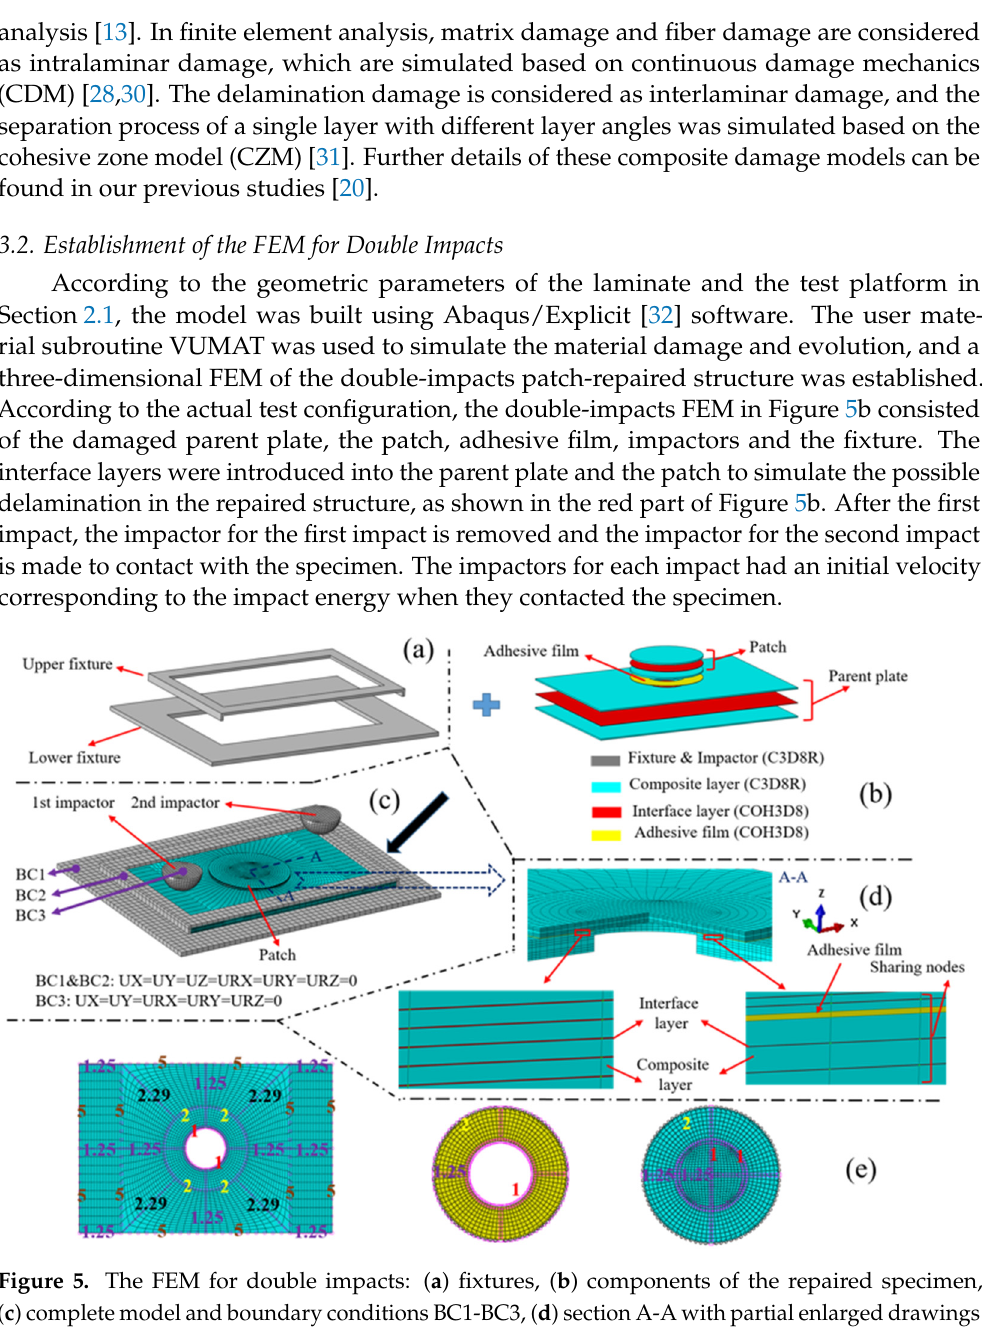
Figure 6. Composite layers and interface layers of ( a ) the parent plate, ( b ) patch and ( c ) adhesive film. 3.3. Material Properties The properties include the parameters used to calculate intralaminar damage, the interlaminar damage of the CFRP laminate and the parameters of the adhesive film. The mechanical properties of each part of the T300/7901CFRP laminate repaired by the patch can be obtained from Ref. [20], as shown in Table 2.